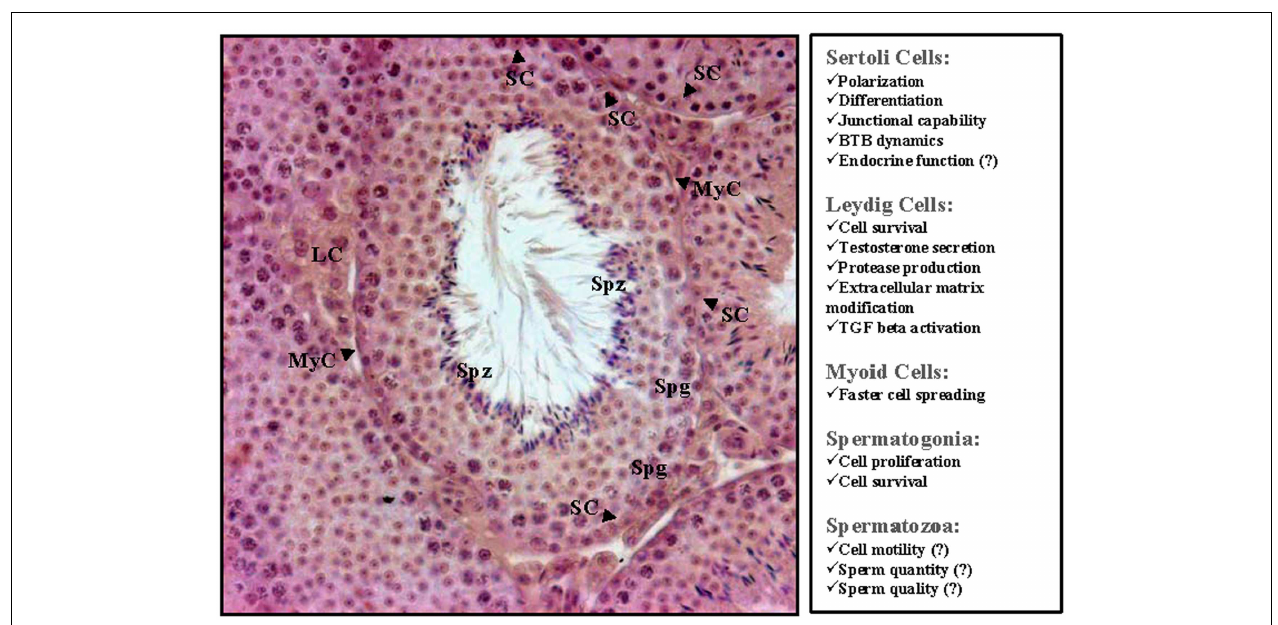
FIGURE 2 | Picture summarizing the main effects exerted by HGF on post-natal testis derived cells . A hematoxylin–eosin stained section of rodent adult testis is also reported. SC, Sertoli cells; LC, Leydig cells; MyC, myoid cells; Spg, spermatogonia; Spz,